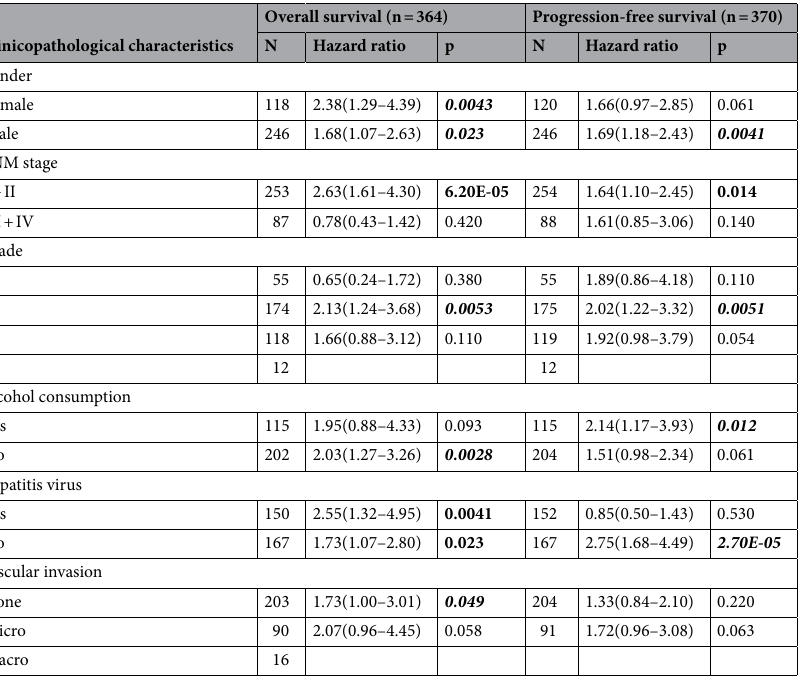
Table 1. Correlation between the HAUS5 expression and pathological features of LIHC in OS and PFS. Bold values indicate p <